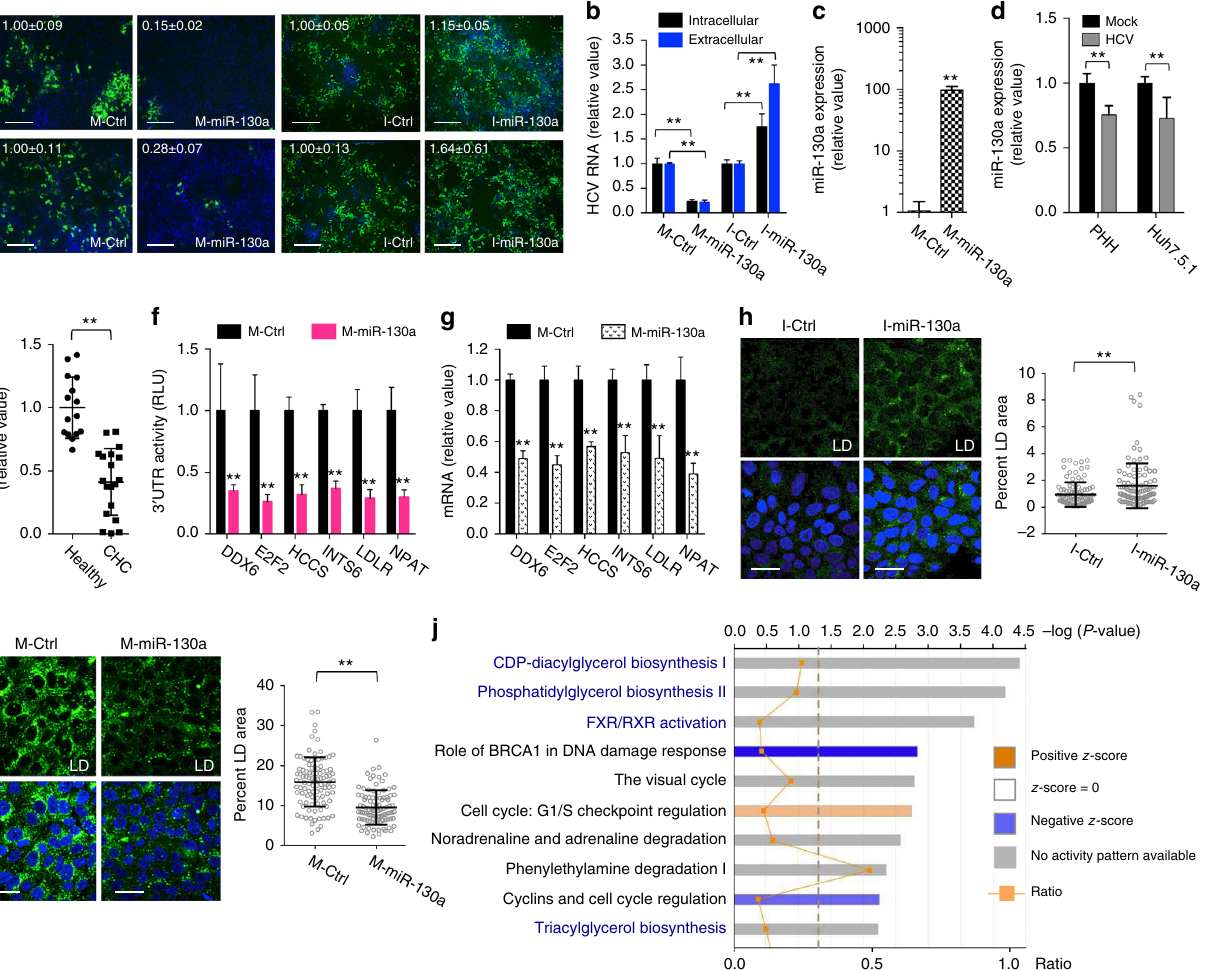
Fig. 6 Identi fi cation of miR-130a that restricts HCV RNA replication and assembly. a , b miR-130a mimic or inhibitor transfection in Huh7.5.1 cells inhibits or enhances HCV infection, respectively. a Part-one and part-two HCV core protein expression were determined by immunostaining. Green, HCV core; blue, nuclei. Scale bars, 100 μ m. b Levels of intracellular and extracellular HCV RNA were measured by Q-PCR. c Transfection ef fi ciency of miR-130a mimic overexpression in Huh7.5.1 cells. d HCV infection decreases miR-130a expression in Huh7.5.1 cells and PHH. e Comparison of hepatic miR-130a abundance between liver samples of CHC patients and those of healthy controls. f , g miR-130a mimic transfection inhibits 3 ′ -UTR activities ( f ) and mRNA levels ( g ) of various predicted cellular targets in Huh7.5.1 cells. h , i Representative images and quantitative analyses of LD contents in Huh7.5.1 cells transfected with control or miR-130a inhibitor ( h ) or mimic ( i ). Green, LDs, stained by BODIPY; blue, nuclei. Scale bars, 100 μ m. 100 cells under each indicated condition were counted and percentages of LD area were measured. i Cells were treated with oleic acid (40 μ M) for 24 h before being stained for LD contents. j Bioinformatics-based pathway analysis was conducted for miR-130a downregulated genes (Supplementary Data 7) using IPA. Values are normalized relative to Ctrl, and error bars represent SD of the mean, n = 3 ( a – d , g ) or 5 ( f ). ** P < 0.01 determined by Student ’ s t